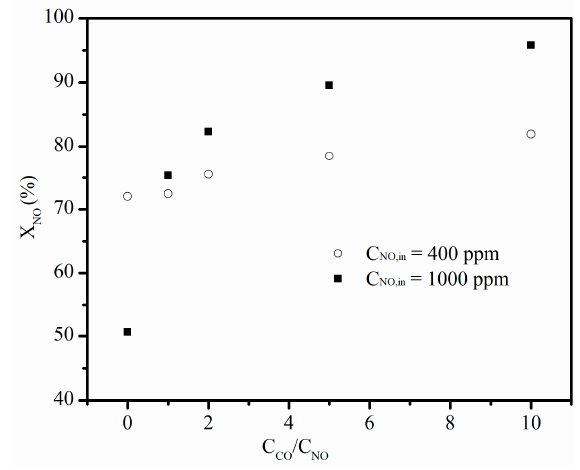
Figure 5. Effect of the initial NO concentration on NO reduction with rice husk char.